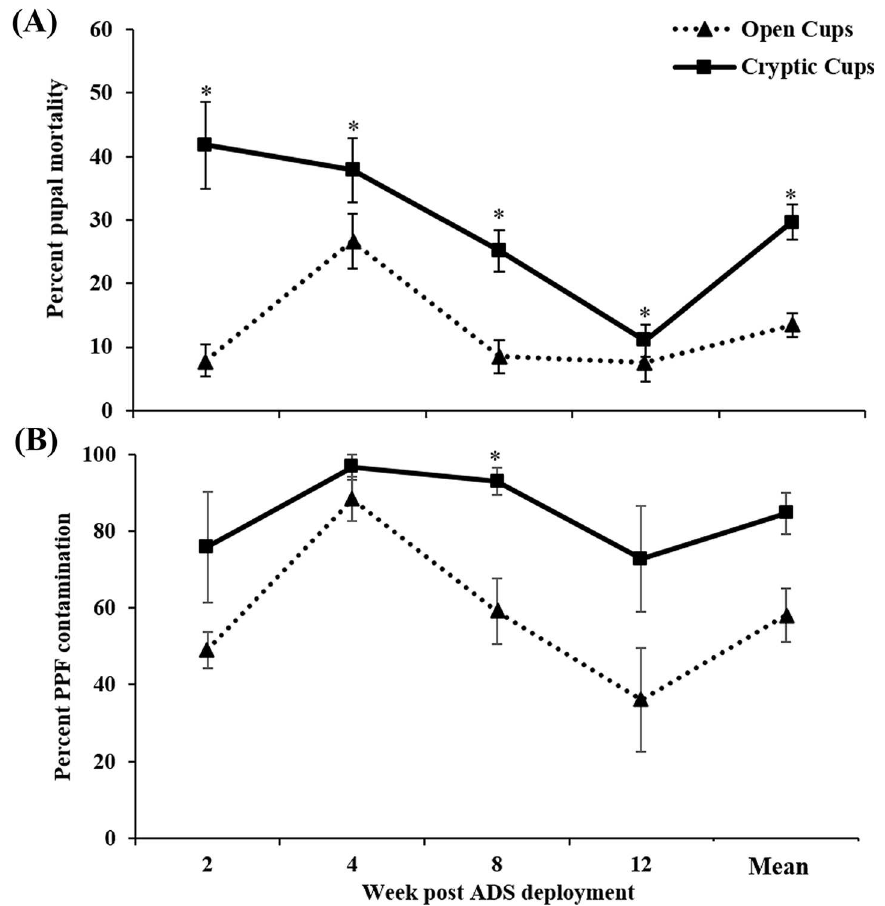
Fig 5. Weekly percent pupal mortality (A) and pyriproxyfen contamination (B) in open and cryptic cups during 2014 field experiment. Significantdifference indicatedby * ( p < 0.05).Data are shown as mean ±